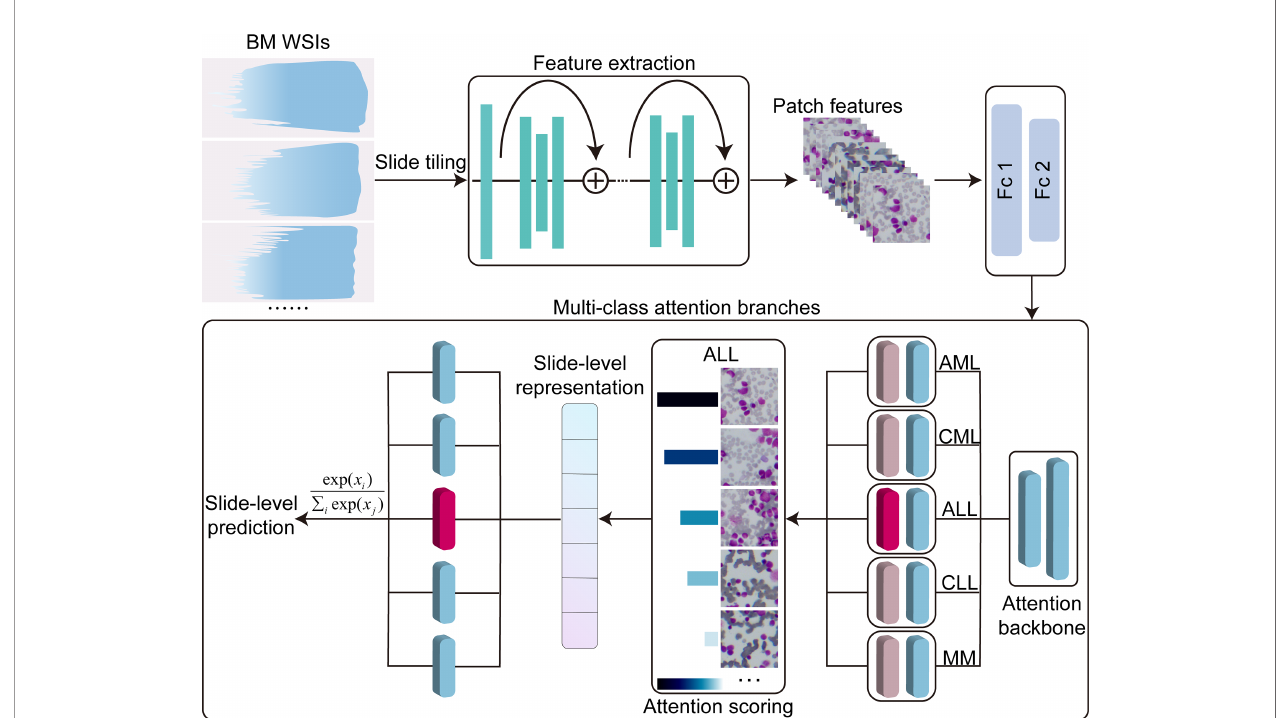
FIGURE 1 | Overview of the model architecture. Bone marrow WSIs were divided into image patches, and then the patches were encoded by a pretrained ResNet50-based CNN fi xed into a low-dimensional feature vectors in the training and inference. Multi-class attention branches assign an attention score to each patch in the WSI based on its importance to the slide-level diagnosis and weigh the importance of the patches by the attention score to aggregate the patch features into a slide level representation. Based on these slide-level representations, the model marked the fi nal diagnostic predictions. Fc1, Fc2, fully connected layers; AML, acute myeloid leukemia; ALL, acute lymphoid leukemia; CML, chronic myeloid leukemia; CLL, chronic lymphoid leukemia; MM, multiple